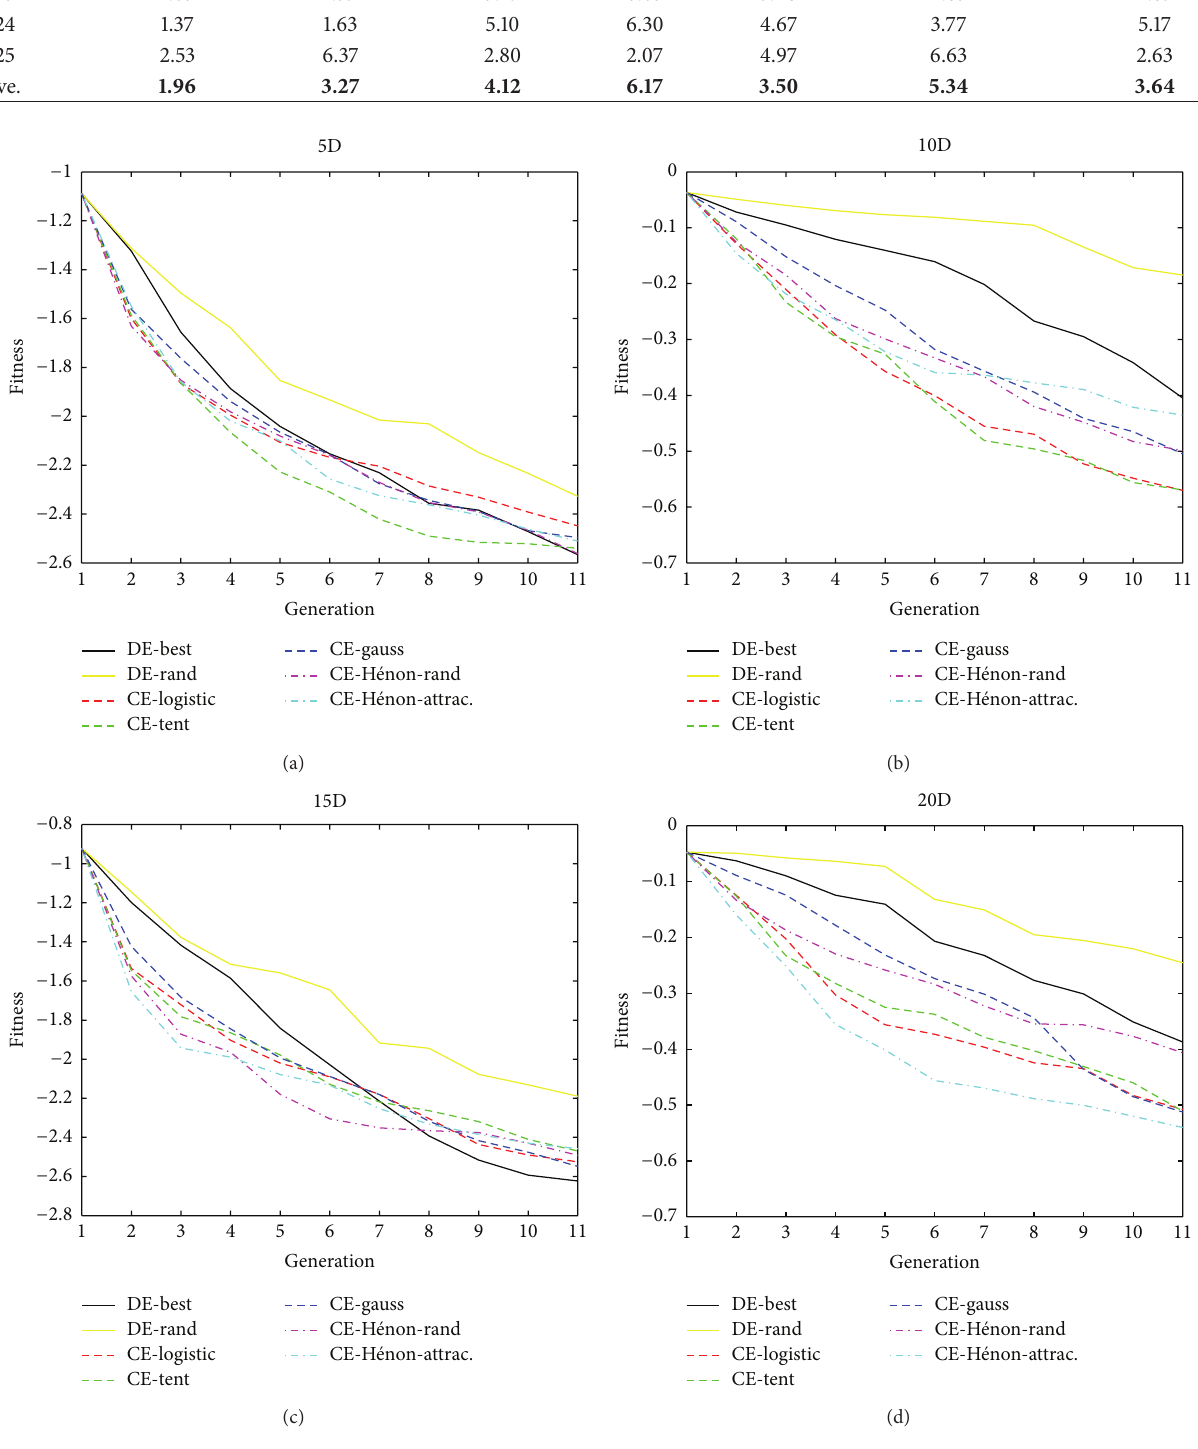
Figure 3: Interactive chaotic evolution convergent curves of 5D, 10D, 15D, and 20D Gaussian mixture model. All the ICE algorithms present fast convergent speed, especially in 10D and 20D tasks. IDE/best can obtain better final results than ICE, but it needs more fitness evaluation (i.e., more human subjective evaluation in IEC application) to find the best base vector. From the metric of fitness evaluation time, ICE is significantly better than IDE/best when these two algorithms call the same fitness function